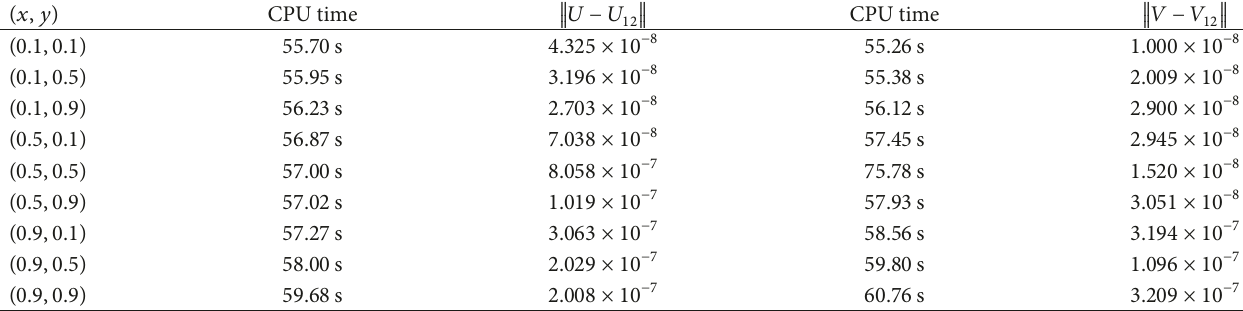
Table 6: Maximum absolute error and CPU times in 𝑈(𝑥, 𝑦) and 𝑉(𝑥,𝑦) of Problem 3 at 𝐾 = 12 corresponding to various values of (𝑥, 𝑦) .